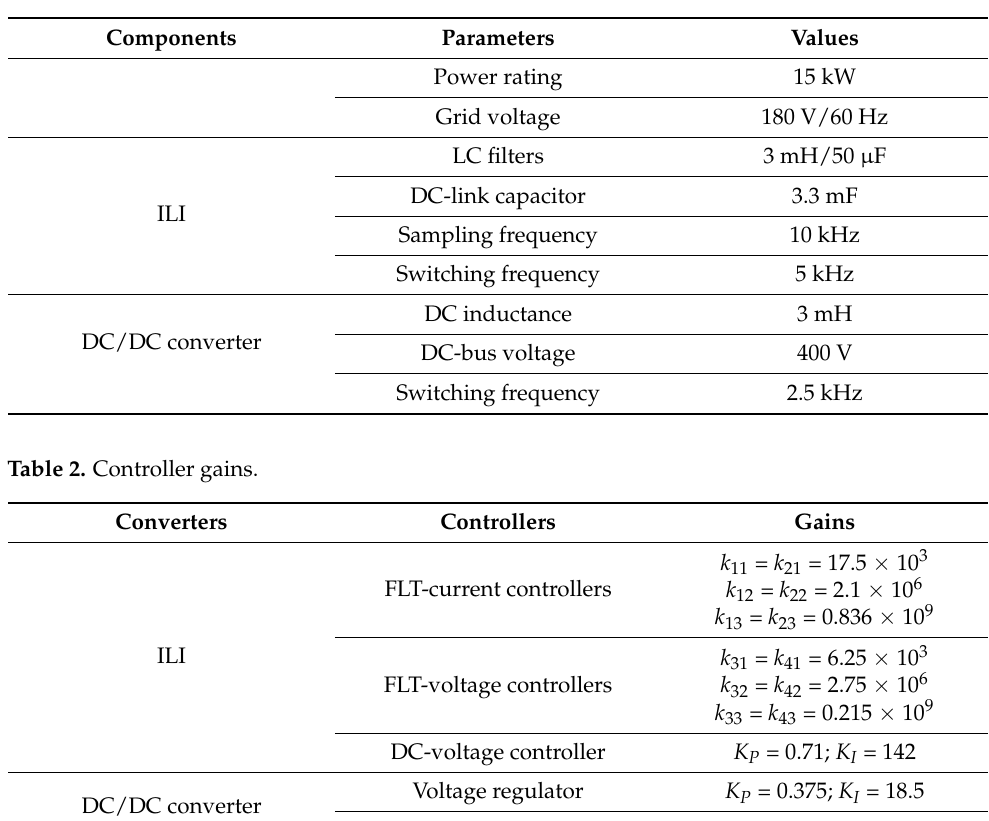
Table 1. Parameters of hybrid microgrid.